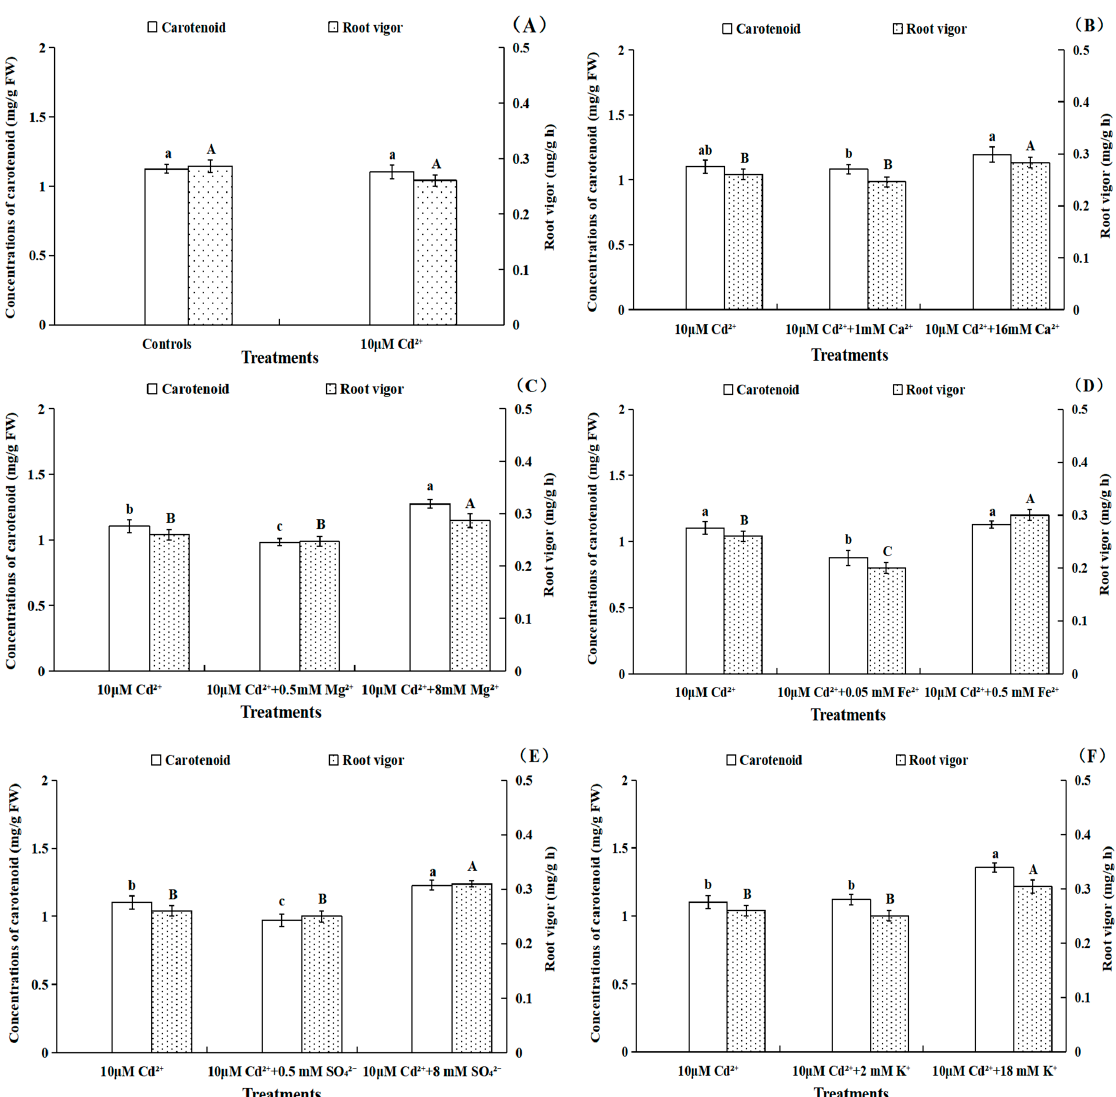
Figure 4. The concentrations of carotenoid and root vigor of Bidens pilosa L. from control groups ( A ) and Cd treatment groups with different concentrations of Ca 2+ ( B ), Mg 2+ ( C ), Fe 2+ ( D ), SO 42 − ( E ) and K + ( F ). under Cd treatments with different nutrient ion levels. Notes: the means of carotenoid concentrations under different treatments marked with the same lowercase letters (a–c) were not significantly ( p > 0.05) different, and the means of root vigor under different treatments marked with the same uppercase letters (A–C) were not significantly ( p > 0.05) different.